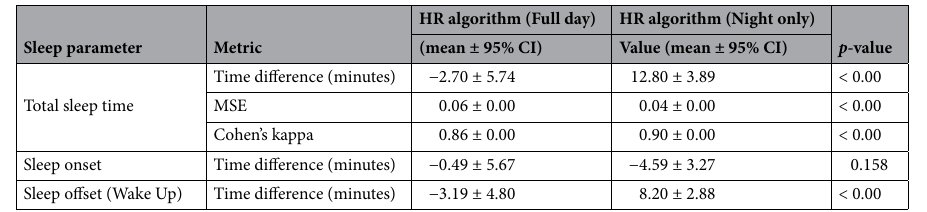
Table 4. Results of applying the HR algorithm on the BBVS dataset for both full-day and night-only data. Comparisons are made against sleep diaries. BBVS TST for diaries mean ± 95% CI = 7.739 ± 0.073 hours (464.34 ± 4.38 minutes).